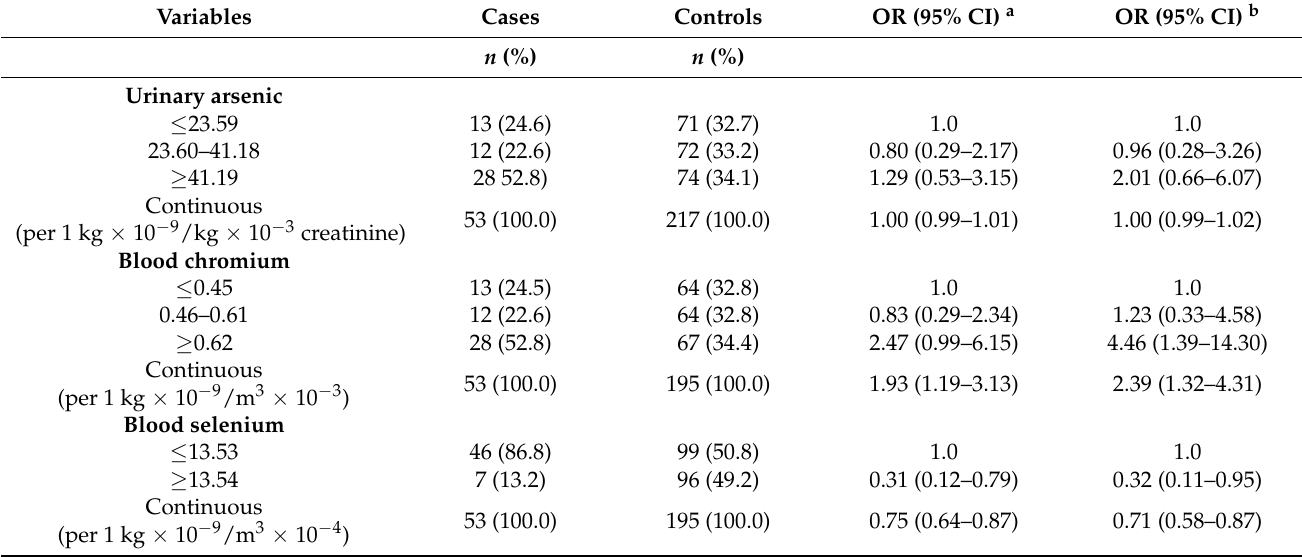
Table 2. Odds ratios (ORs) and 95% confidence intervals (CIs) for the association of creatinine-